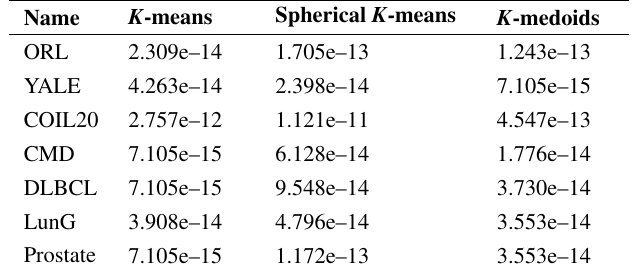
Table 4 The comparison of the objective functions on the actual